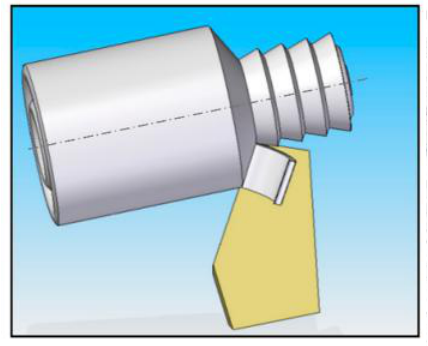
Figure 2. The principle of oblique